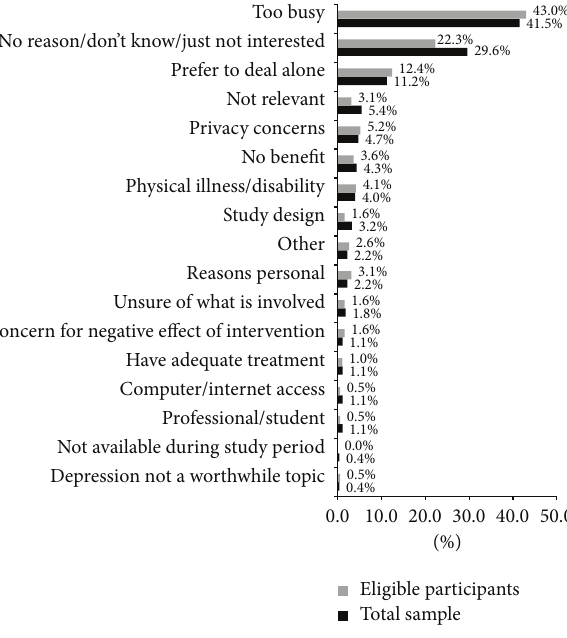
Figure 2: Factors reported as discouraging participation.